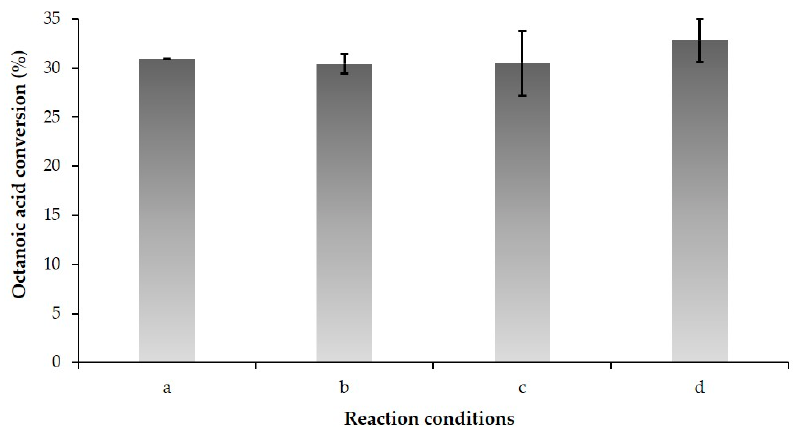
Figure 4. Octanoic acid conversion after 48 h of reaction for different feed conditions of thymol and CALB; ( a ) thymol and CALB solution in one stage, ( b ) thymol in one stage and CALB solution in two stages, ( c ) CALB solution in one stage and thymol in two stages, ( d ) thymol and CALB solution in two stages. Reaction conditions: 2 mmol octanoic acid, 50 °C, magnetic stirring at 200 rpm.